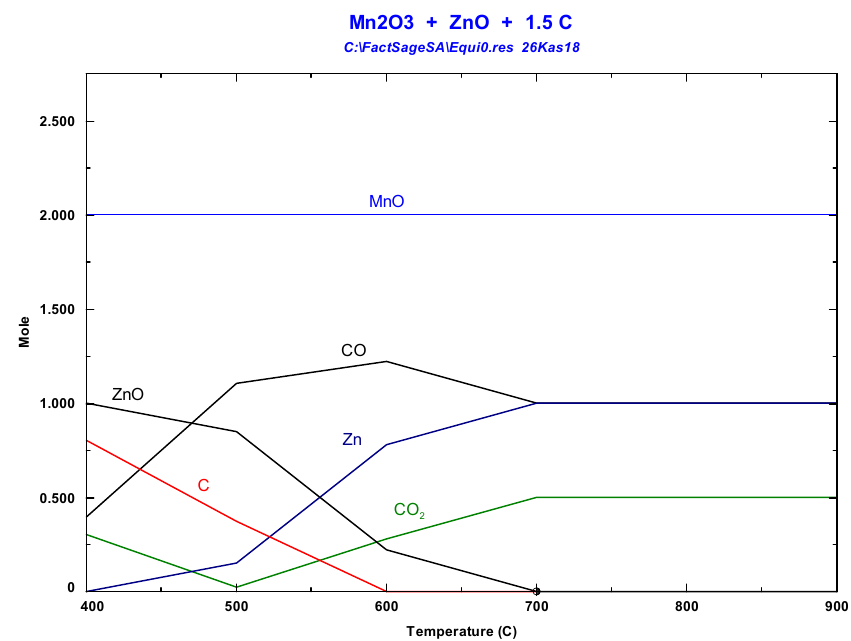
Figure 3. The change of reaction products with increasing process temperature for 10 Pa vacuum conditions.